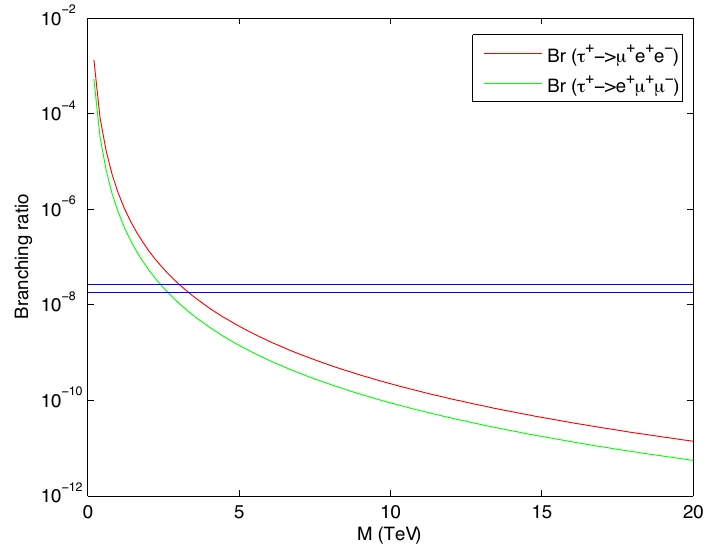
Figure 2 . Dependence of the branching ratios Br( (cid:28) ! e(cid:22)(cid:22) ) and Br( (cid:28) ! (cid:22)ee ) on the new neutral gauge boson mass, m Z 0 (cid:17) M . Here, the blue lines correspond to the current upper limits Br( (cid:28) ! e(cid:22)(cid:22) ) (cid:20) 2 : 7 (cid:2) 10 (cid:0) 8 and Br( (cid:28) ! (cid:22)ee ) (cid:20) 1 : 8 (cid:2) 10 (cid:0) 8 , respectively. Br( (cid:28) ! (cid:22)ee ) (cid:20) 1 : 8 (cid:2) 10 (cid:0) 8 are also shown as blue lines [72]. The lower limits for m